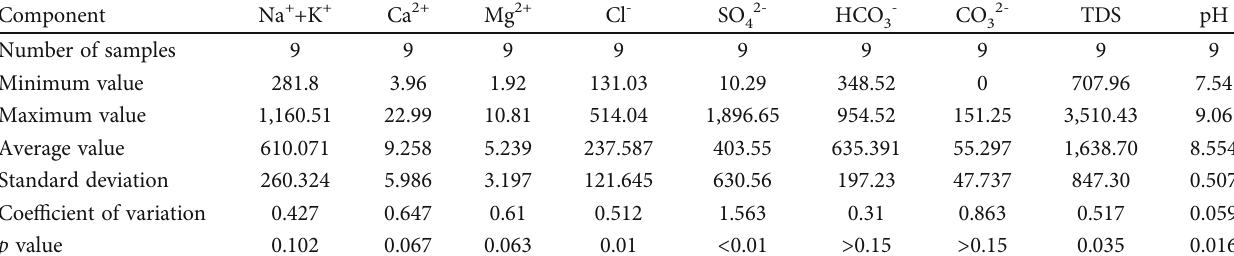
Table 4: Statistical characteristics of coal bearing sandstone aquifer in experimental coal mine.